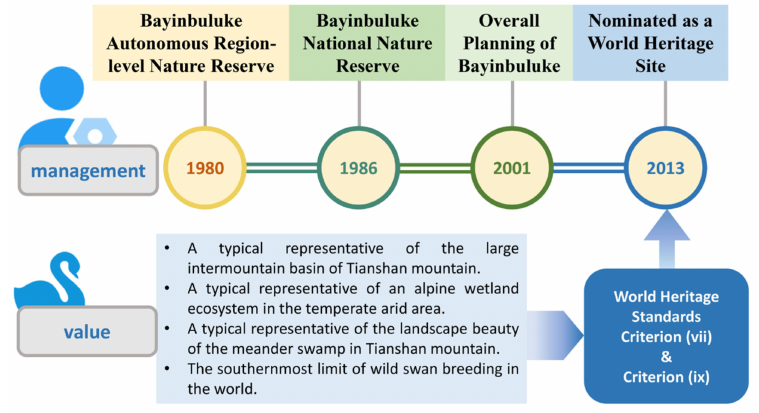
Figure 2. Bayinbuluke Management History and World Heritage Values.